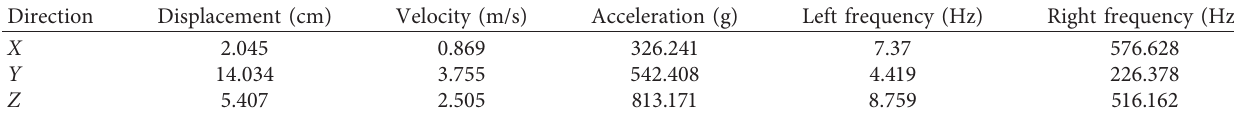
Table 5: Average value of design spectrum in all directions of inner bottom